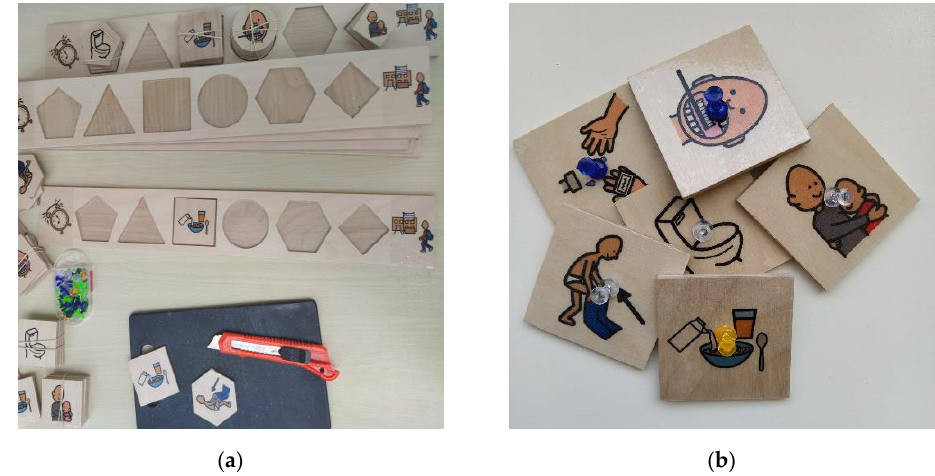
Figure 13. ( a ) Sticking the stickers and putting pins; ( b ) wooden pieces with pins.